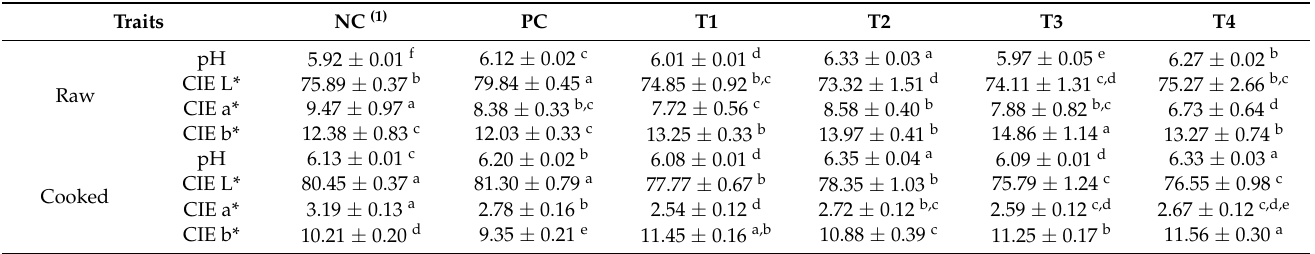
Table 2. Effects of grafted insect protein and eggshell powder on pH and color of phosphate-free meat emulsion.